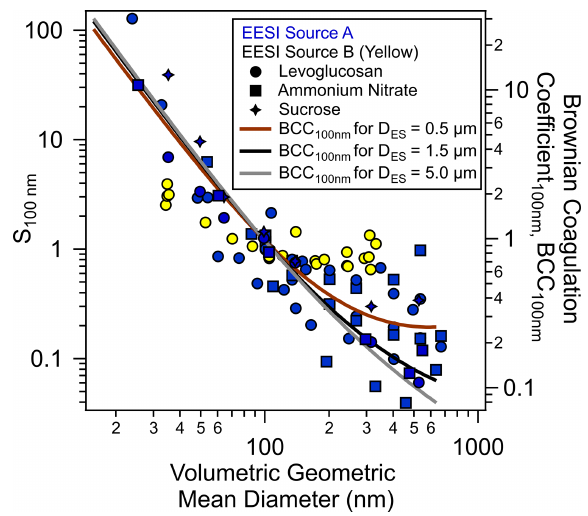
Figure 2. Sensitivities of the EESI-TOF towards various standards normalized to their respective values at 100nm as a function of the particle volumetric geometric mean diameter. Blue and yellow markers indicate EESI sources A and B, which were initially devel- oped for TOF and Orbitrap mass analyzers, respectively (Lopez- Hilfiker et al., 2019; Lee et al., 2020). Different marker types ( ), ( (cid:4) ), ( ) denote levoglucosan, NH 4 NO 3 and sucrose, respec- tively. The Brownian coagulation coefficients are calculated using the range of ES parent droplet sizes estimated based on our ES op- erating parameters (Figs. S6 and S7). Note that some of the data points may overlap at the similar volumetric geometric mean diam- eter due to repetitions of the same experiment settings.